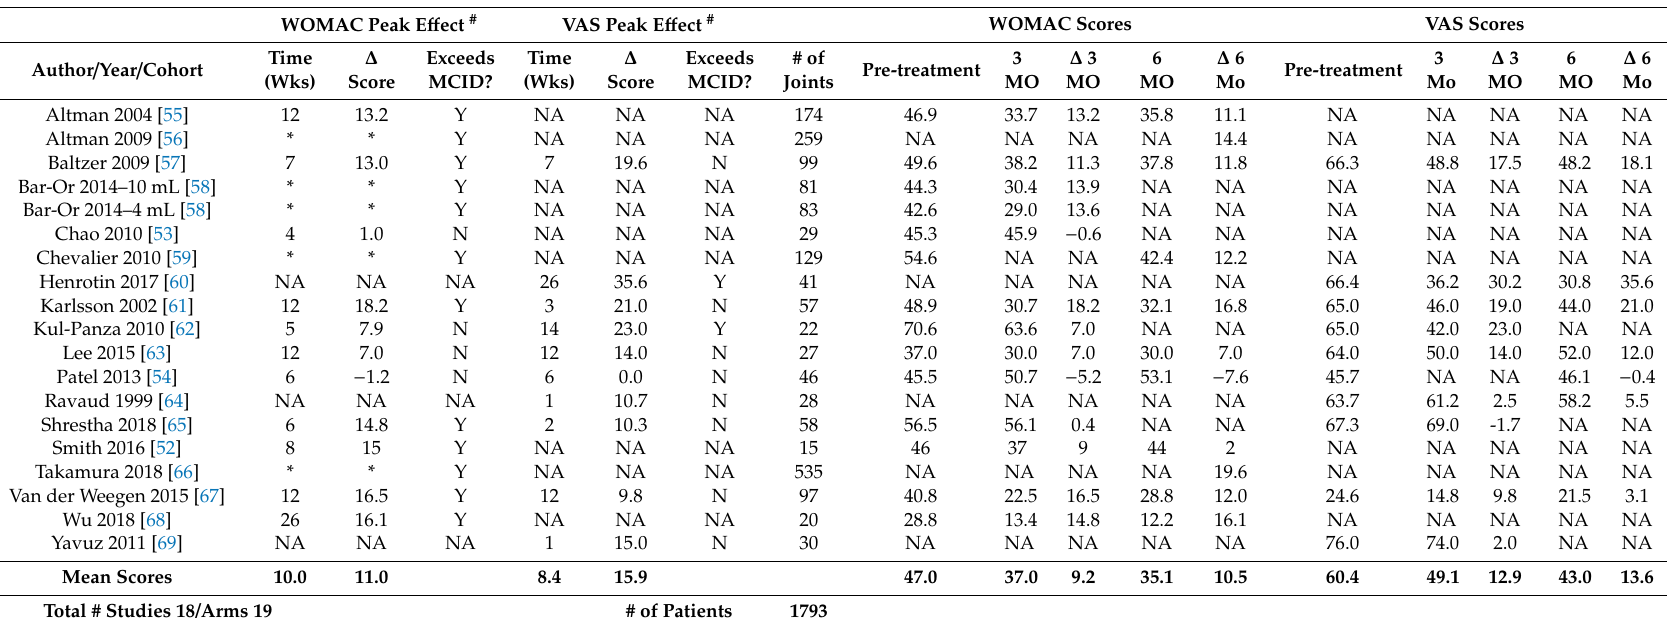
Table 3. Group 3 studies—placebo arms of placebo-controlled trials of injectate treatments for knee